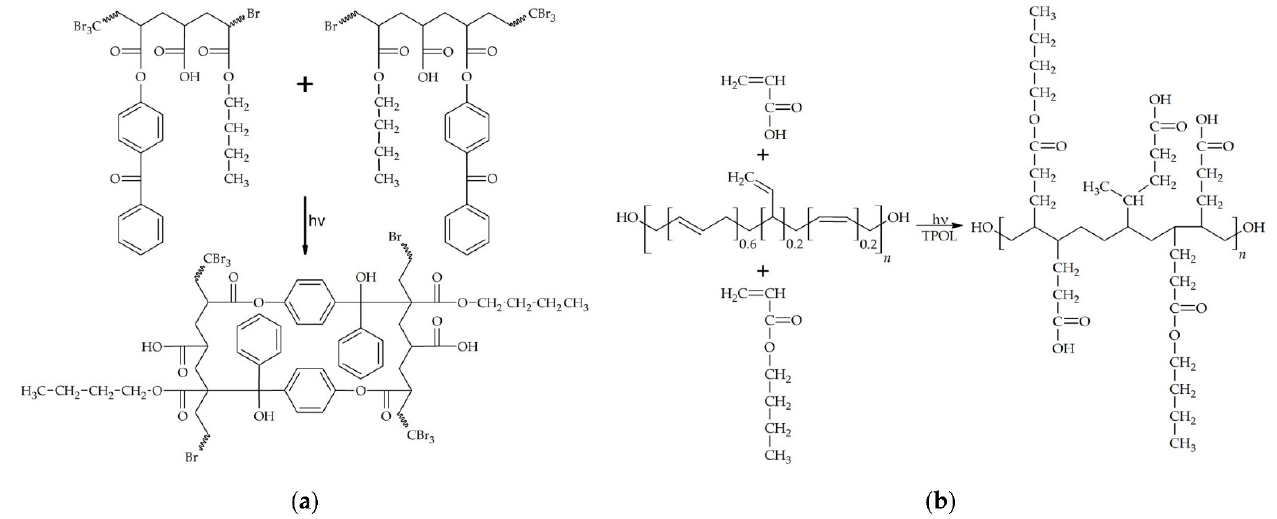
Figure 3. Photocrosslinking of pressure-sensitive adhesives: ( a ) via copolymerizable photoinitiator ABP (hydrogen abstractor) and ( b ) via HTB and unreacted monomers [23]. Self-adhesive tests (i.e., adhesion to steel at 180°, tack, cohesion at 20 °C and 70 °C, and shear adhesion failure test) of UV-crosslinked PSAs were performed. Adhesion to steel at a 180° (also called peel adhesion) was determined at room temperature using the Zwick/Roell Z010 testing machine (Zwick/Roell, Ulm, Germany) according to the AFERA 5001 (standard developed by the European Association des Fabricants Europeens de Rubans Auto-Adhesifs—AFERA). The degreased steel plate was applied with a one-sided PSA film measuring 175 × 25 mm and pressed with a 2 kg rubber roller. The test was performed 20 min after the application of the film to the plate with a peeling speed of 300 mm/min. Tack values were determined using the Zwick/Roell Z010 testing machine (Zwick/Roell, Ulm, Germany) according to AFERA 5015 standard. PSA film with dimensions of 175 × 25 mm was mounted in the upper jaws to obtain loops with the adhesive layer on the outside. In the lower jaws, a degreased steel plate was placed perpendicularly to the sample, which was lowered perpendicularly at a speed of 100 mm/min. The contact area was about 6.25 cm 2 . The machine recorded the force needed to detach the adhesive film after a short contact with the steel surface, without external forces. The cohesion of PSAs (shear resistance) was measured according to the AFERA 5012 standard, with a device developed by the West Pomeranian University of Szczecin that measures the time when joint cracks occur automatically. A one-sided adhesive film was applied to the degreased steel plate to form a 25 × 25 mm (6.25 cm 2 ) joint and pressed with a 2 kg rubber roller to improve wettability. A 1 kg weight was